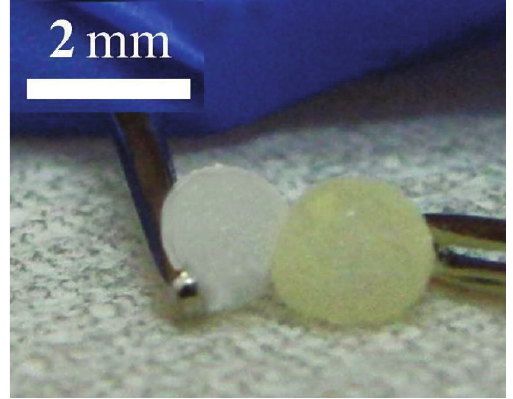
Figure 1: 10 𝜇 L Teflon (white) and lycopodium (yellow) coated marbles do not coalesce even when pressed one to